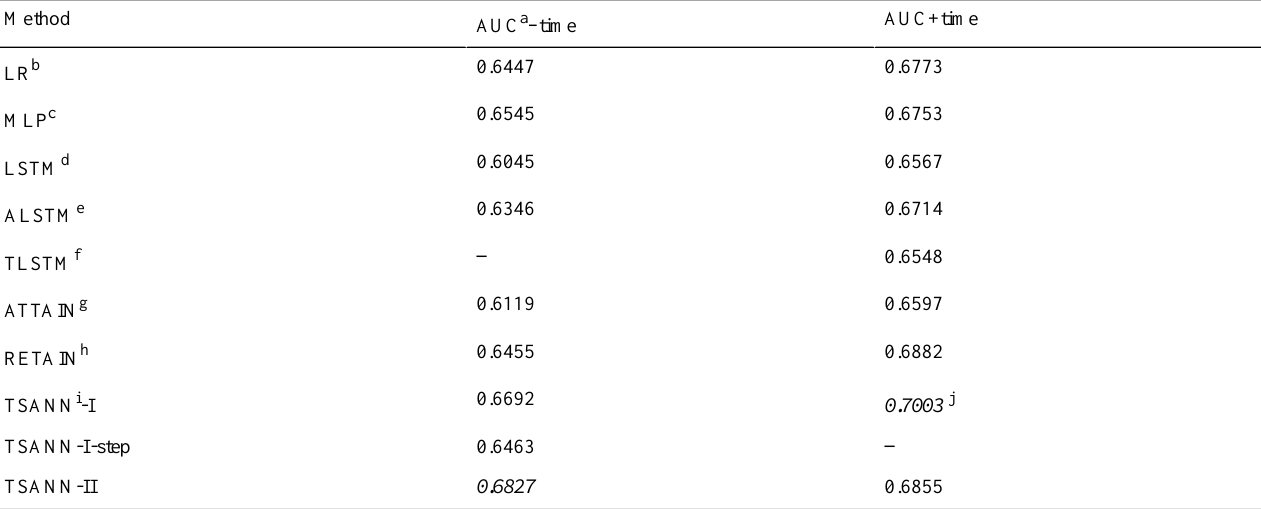
Table 3. Area under the curve (AUC) values by different models (–time: time information was excluded and +time: time information was